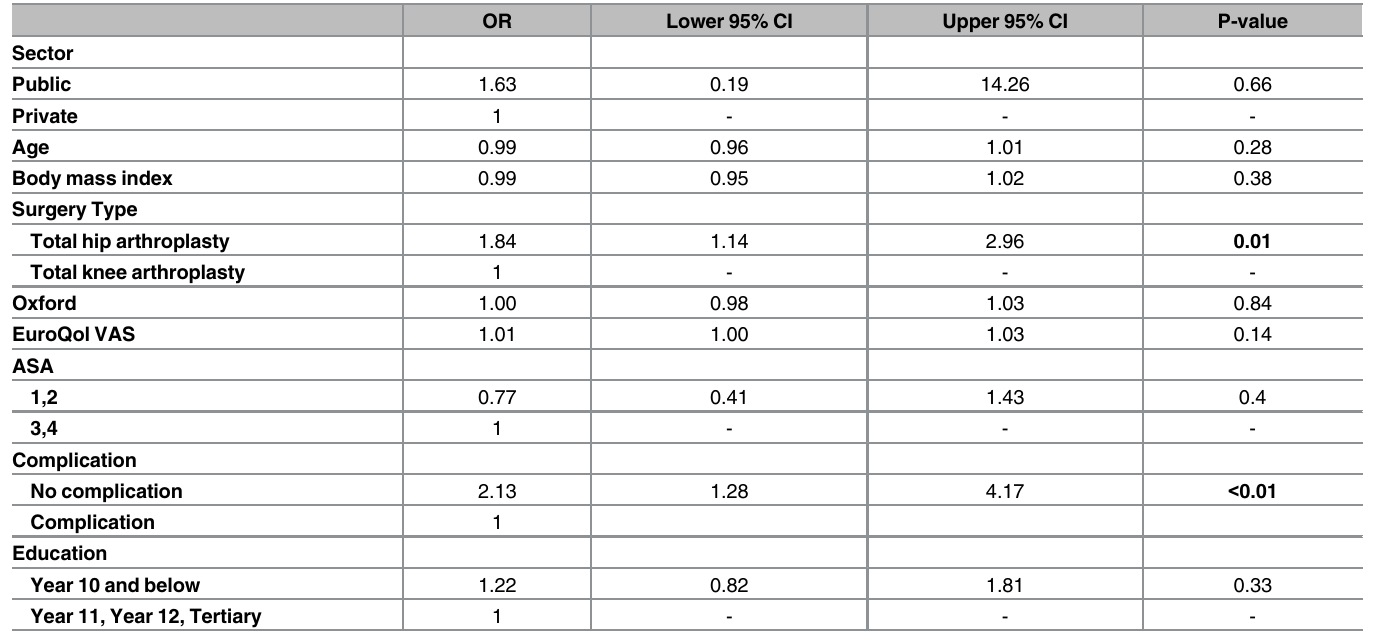
Table 5. Multivariate analyses for the prediction of future recommendation of the same hospital to others ( ‘ Definitely recommend ’ or ‘ Other ’ ). OR